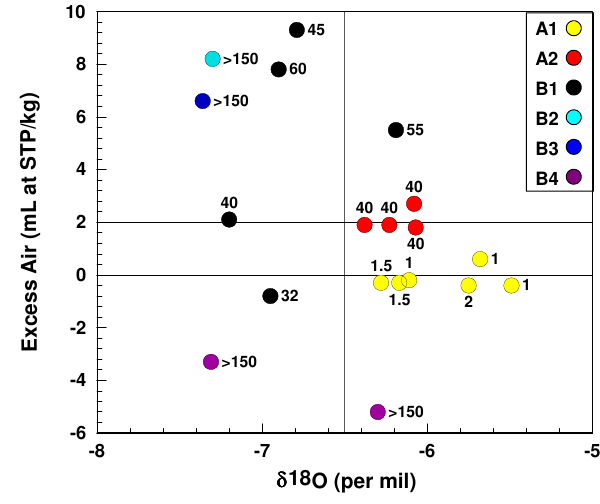
Fig. 10. Relationships between the hydrochemical clusters defined in this study and previous measurements of δ 18 O, excess air (based on measured concentrations of dissolved nitrogen and argon) and mean residence time (in years, shown by the data point labels, and based on measured concentrations of tritium, chlorofluorocarbons and sulfur hexafluoride).